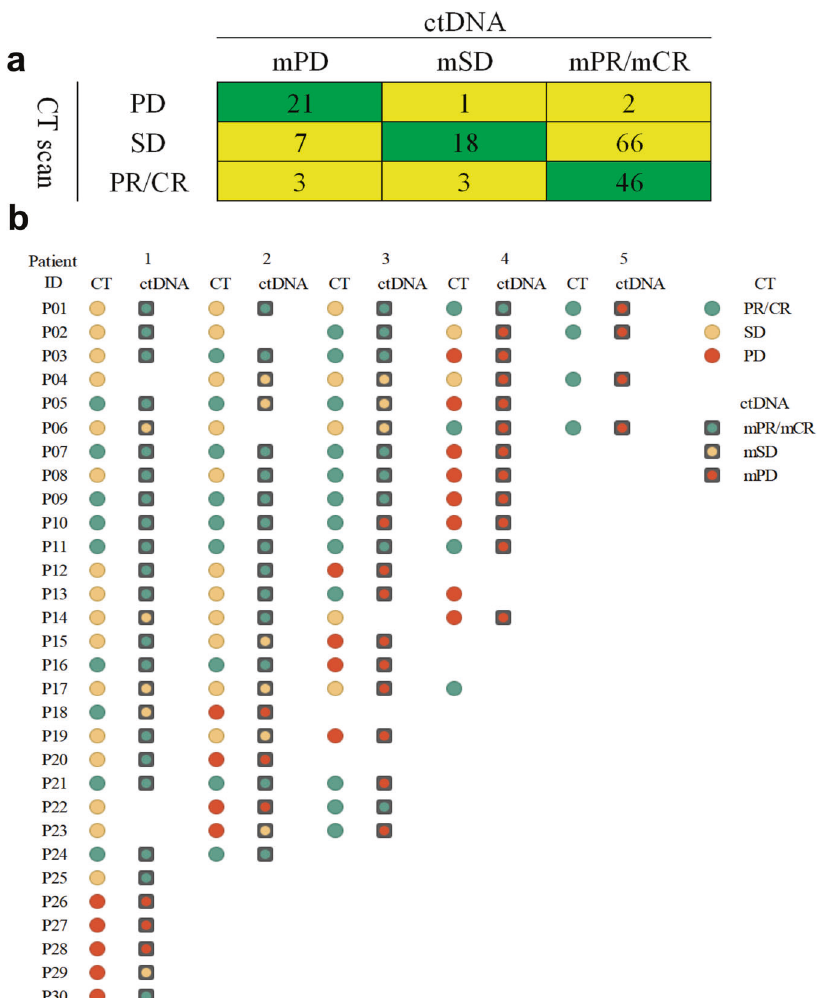
Fig. 3 mTBI evaluated ef fi cacy compared to CT scan data. The evaluations based on mTBI values compared with those based on CT scans in all of the patients ( a ) and in 31 patients who had serial plasma samples ( b ). CT computed tomography, ctDNA circulating tumor DNA, mTBI molecular tumor burden